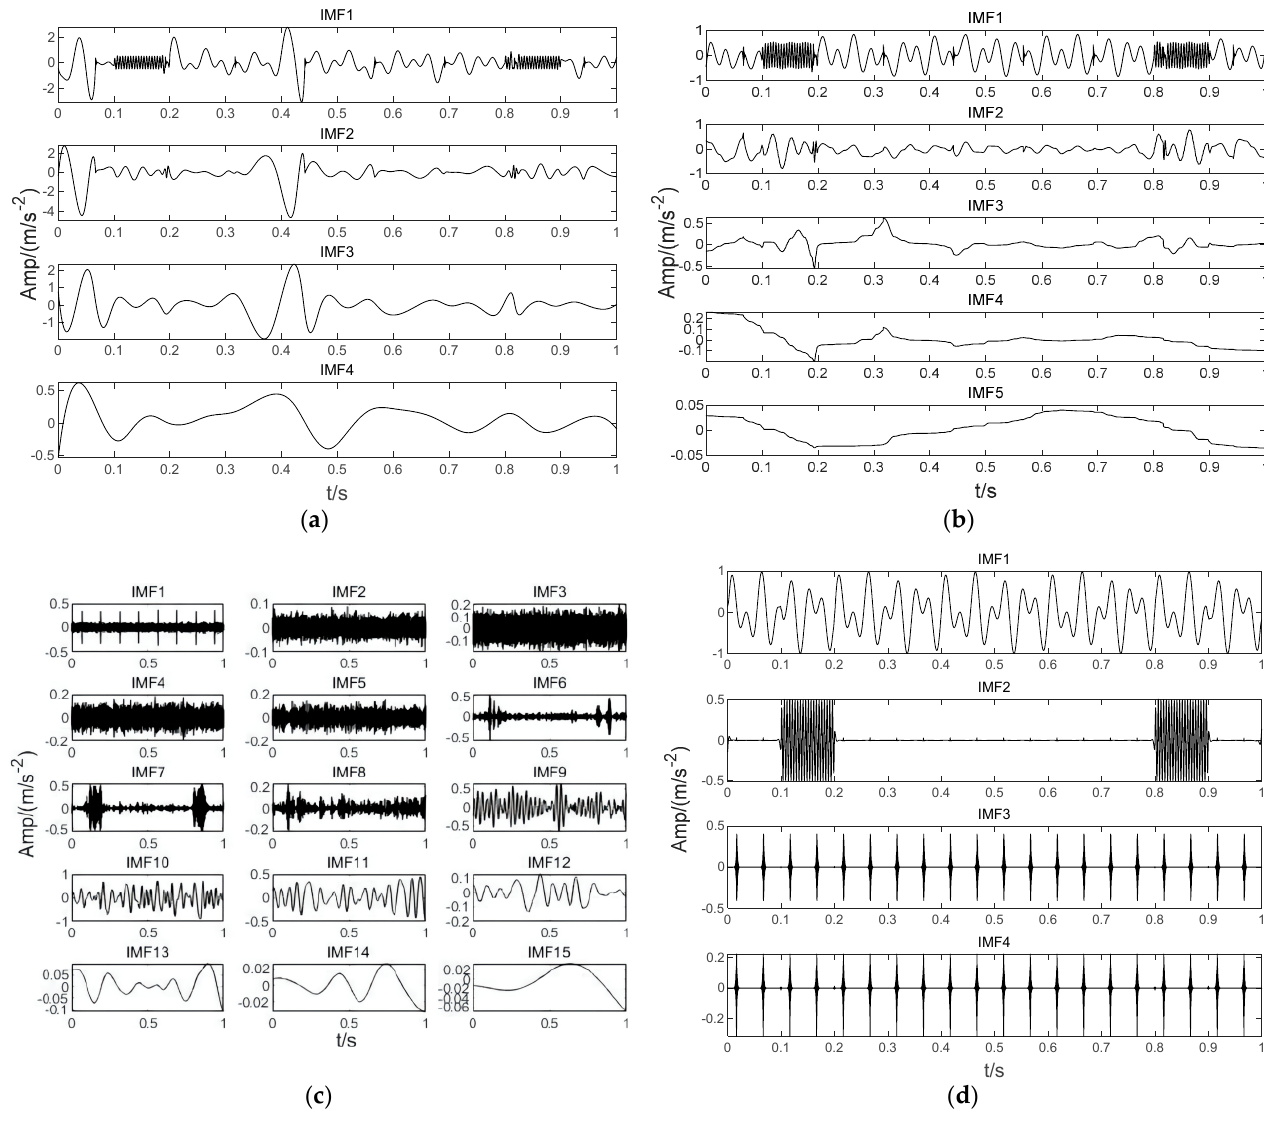
Figure 13. Performance evaluation of other state-of-art methods. ( a ) The components obtained by LMD. ( b ) The components obtained by ITD. ( c ) The components obtained by CEEMDAN. ( d ) The components obtained by SVMD.